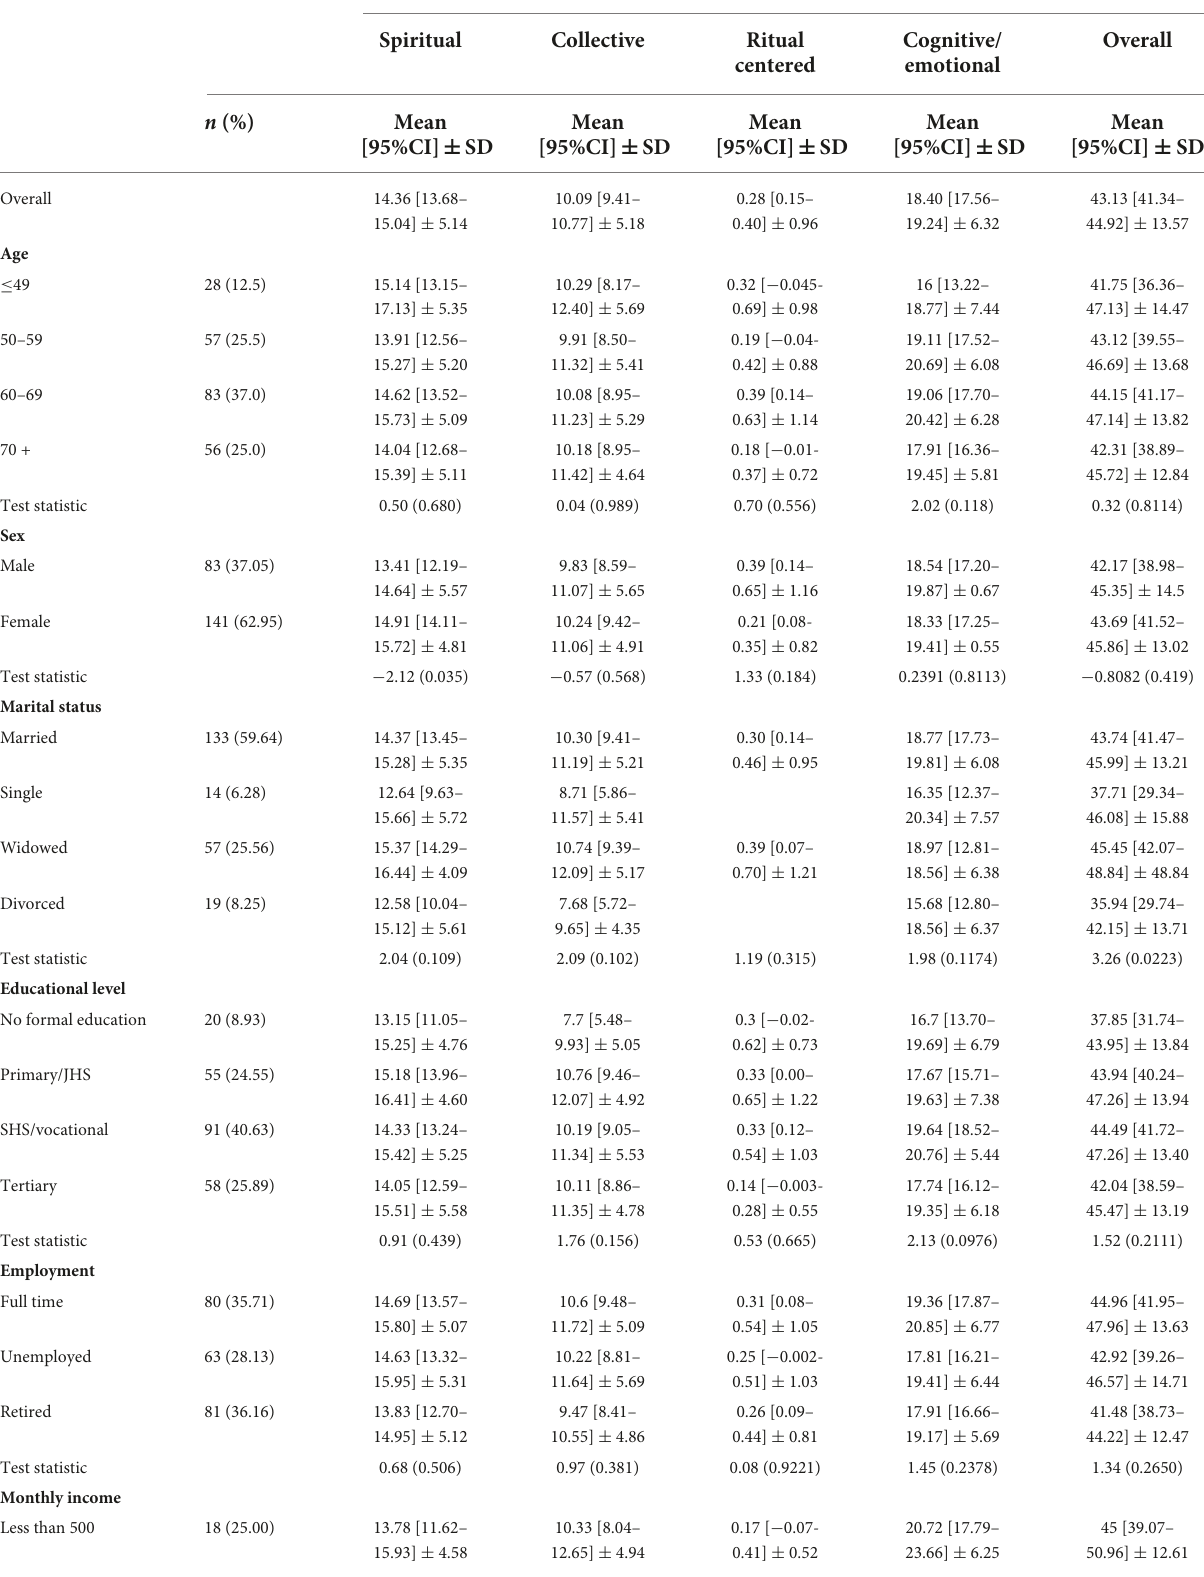
TABLE 1 Demographic characteristics and the mean difference of coping strategies among